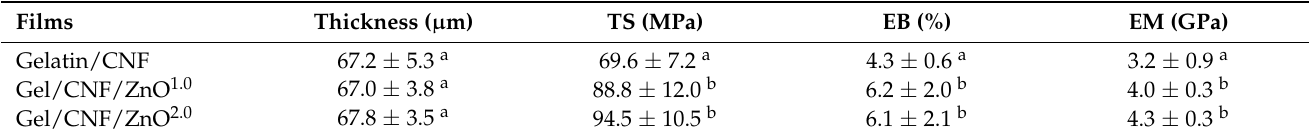
Table 2. Mechanical properties of the gelatin/CNF-based films.